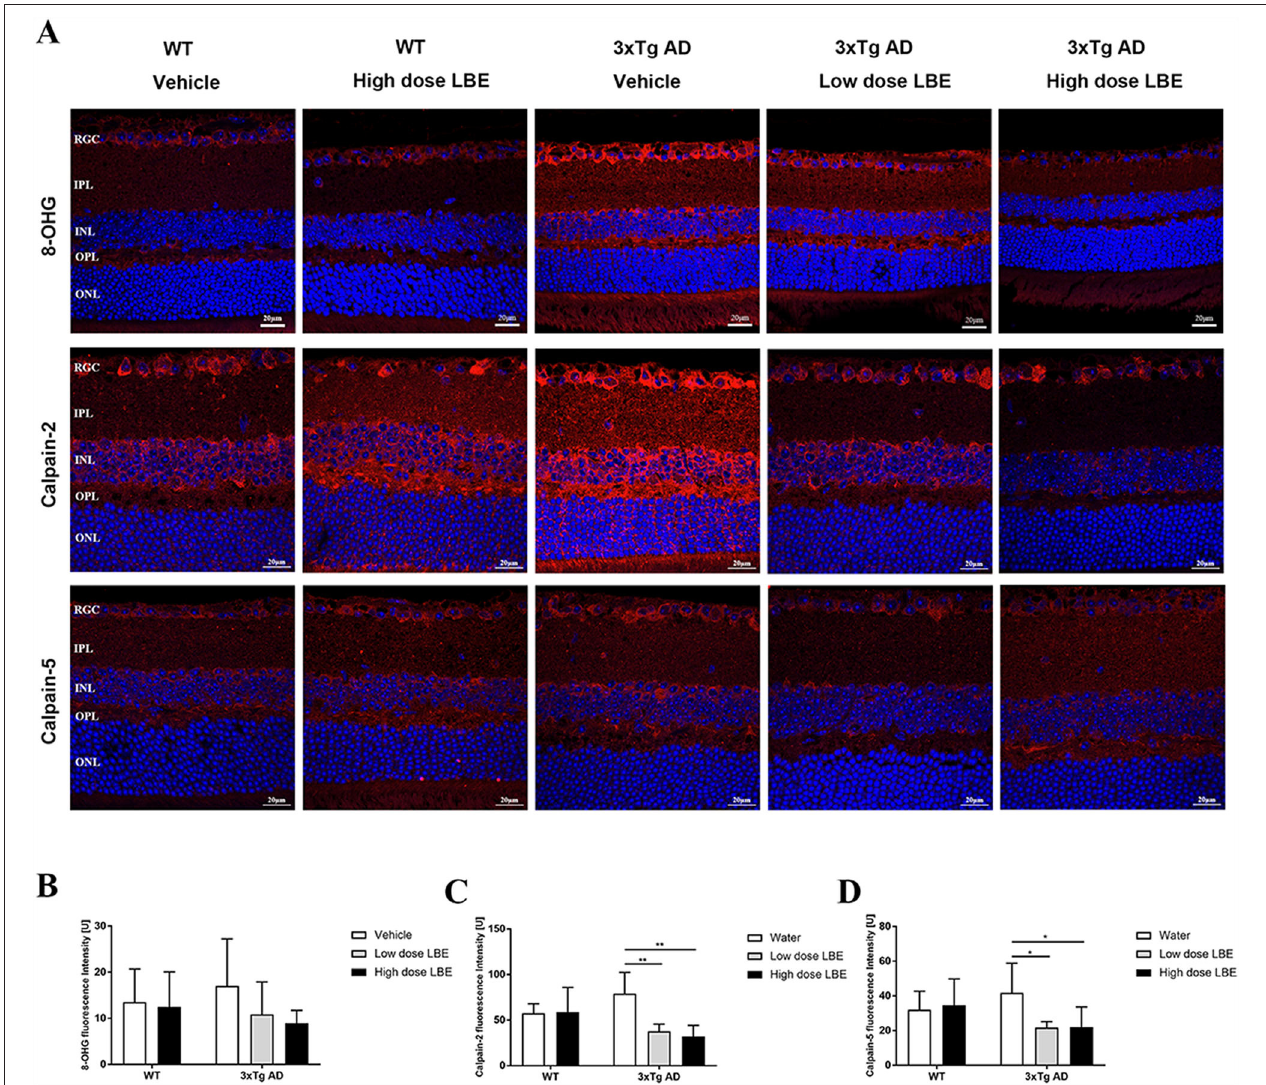
FIGURE 3 | Two months LBE oral feeding downregulated expression of 8-OHG, calpain-2, and calpain-5 in 3xTg-AD mice at the age of 8 months. (A) Representative images of 8-OHG, calpain-2, and calpain-5 stained retinal sections of 3xTg-AD mice and age matched non-Tg control mice fed with water, low dose LBE or high dose LBE. Semi-quantification analysis showed increased 8-OHG (B) , calpain-2 [ (C) , * P < 0.05; ** P < 0.01], and calpain-5 [ (D) , * P < 0.05; ** P < 0.01] in the retinas of 3xTg-AD mice, which could be suppressed by LBE